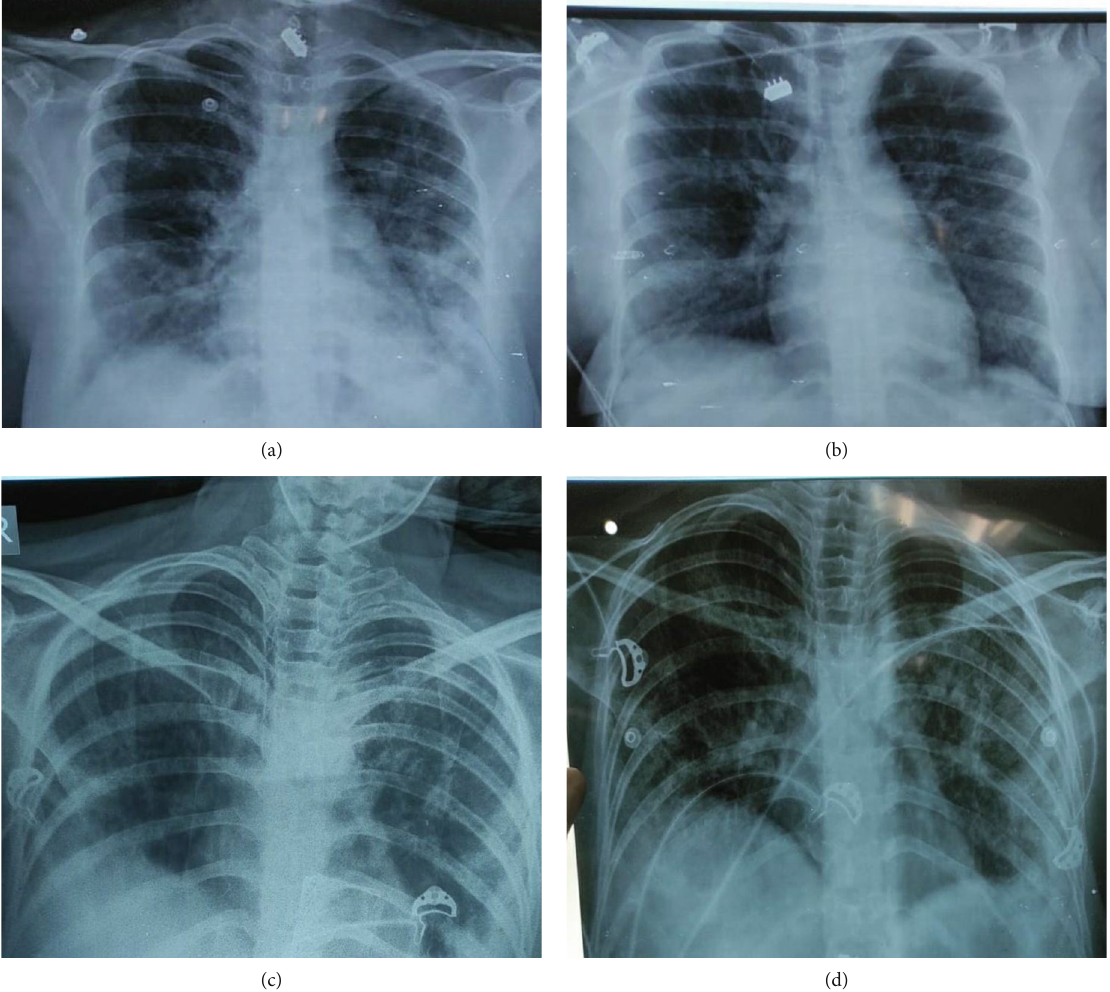
Figure 1: Radiological fi ndings: (a) postnatal day 7, (b) postnatal day 11, (c) postnatal day 30, and (d) postnatal day